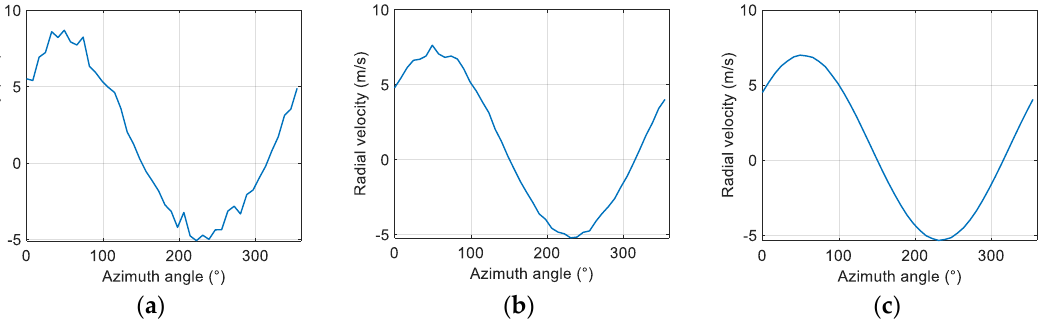
Figure 4. Variation of radial velocity with azimuth angle in uniform wind field under different signal-to-noise rations (SNRs). ( a ) SNR = 5 dB; ( b ) SNR = 10 dB; ( c ) SNR = 20 dB.